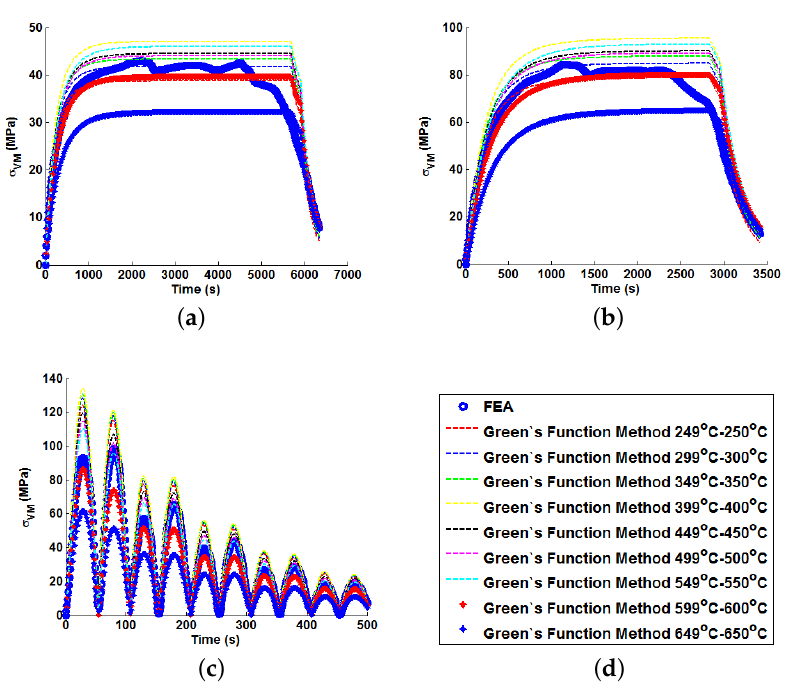
Figure 10. Predictions of thermal stress responses determined using individual Green’s functions for: ( a ) ramp up Profile G; ( b ) ramp up Profile H; and ( c ) oscillating Profile I. Sub figure ( d ) shows the legend used in the plots.